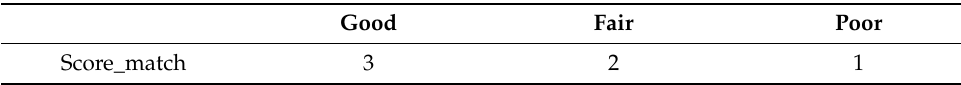
Table 2. The Score_match of different situations. Good Fair Poor Score_match 3 2 1